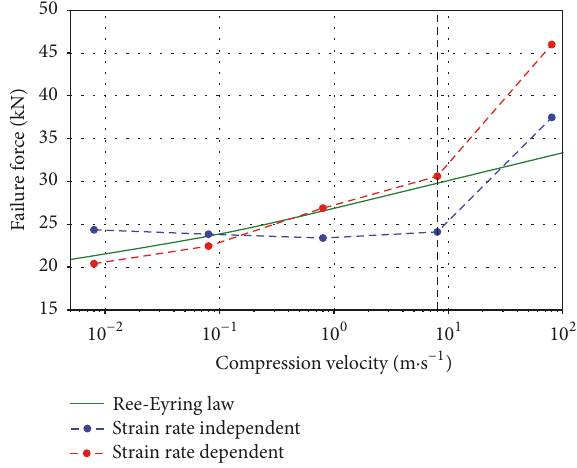
Figure 8: Failure force for different compression velocities on a cylindrical specimen: comparison of the strain rate dependent and strain rate independent